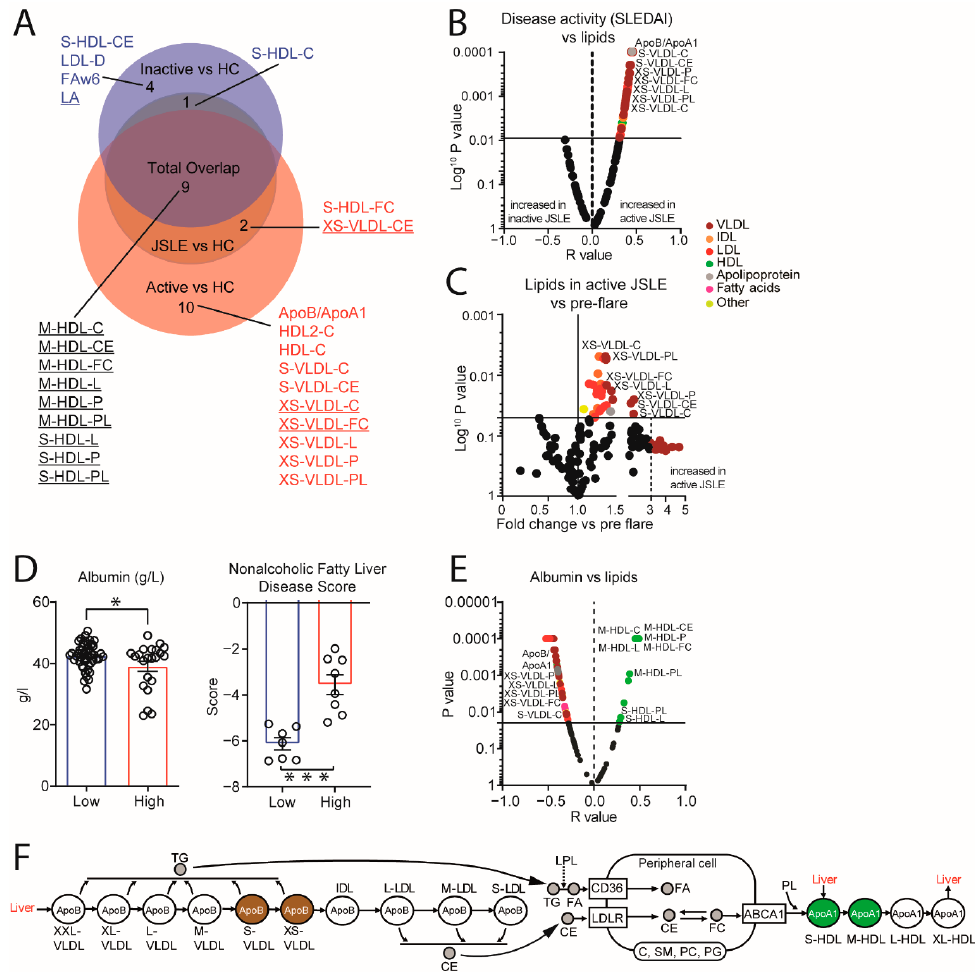
Figure 3. Atherogenic lipoproteins correlate positively with markers of JSLE disease activity and are associated with markers of liver damage. ( A ) Venn diagram (http://www.biovenn.nl/, Accessed on